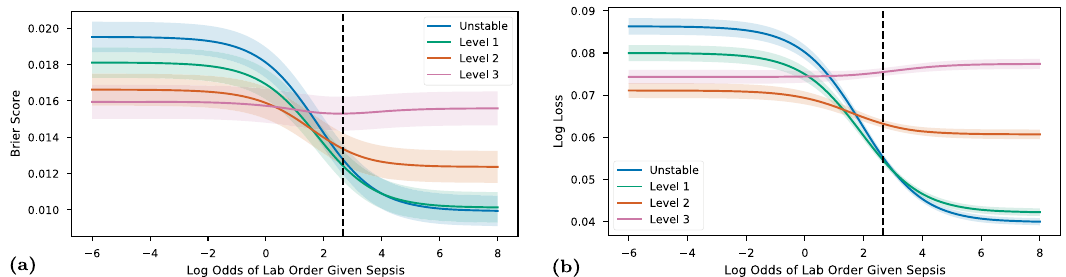
Figure 4: ( a ) Performance ( Brier score ) of di ff erent models vs log - odds of lab order for the shift in Figure 3. Vertical dashed line denotes training value. Shaded regions denote 95% con fi dence intervals. ( b ) Performance ( log loss ) of di ff erent models vs log - odds of lab order for the shift in Figure 3. Note that the level 3 model is minimax optimal in ( a ) while it is not in ( b )